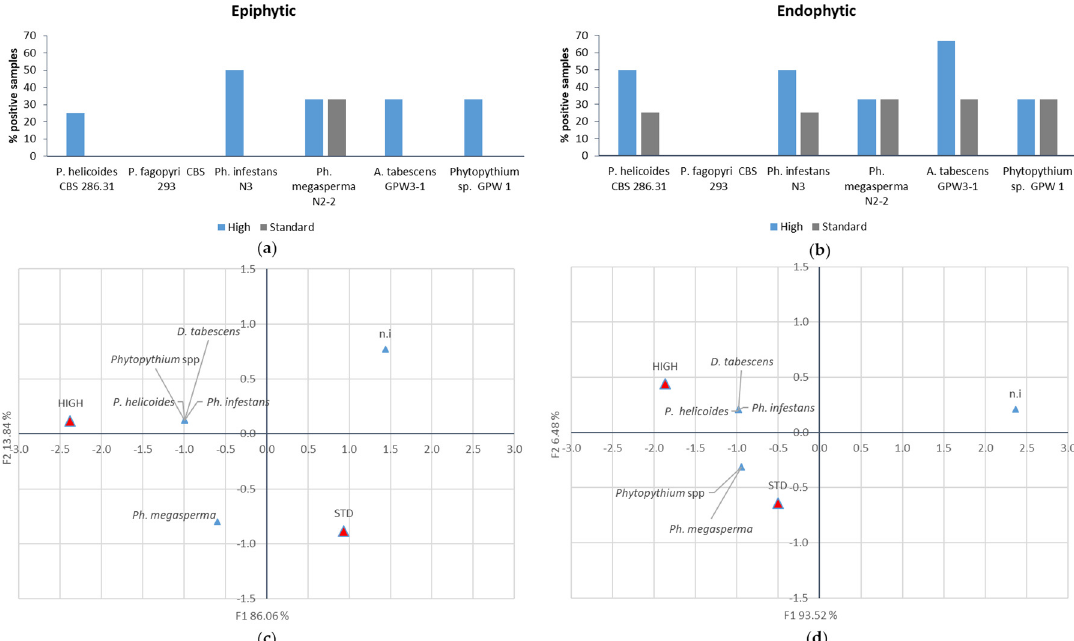
Figure 6. Incidence of epiphytic ( a ) and endophytic ( b ) colonisation expressed as percentage of positive samples (%) in high irrigation (HIGH) input standard strategies (STD) after experimental inoculation. Two-dimensional principal component analysis (PCA) describing the distribution of samples based on water input (HIGH or STD) and the re-isolated populations on the surface ( c ) or inside ( d ) kiwifruit roots.